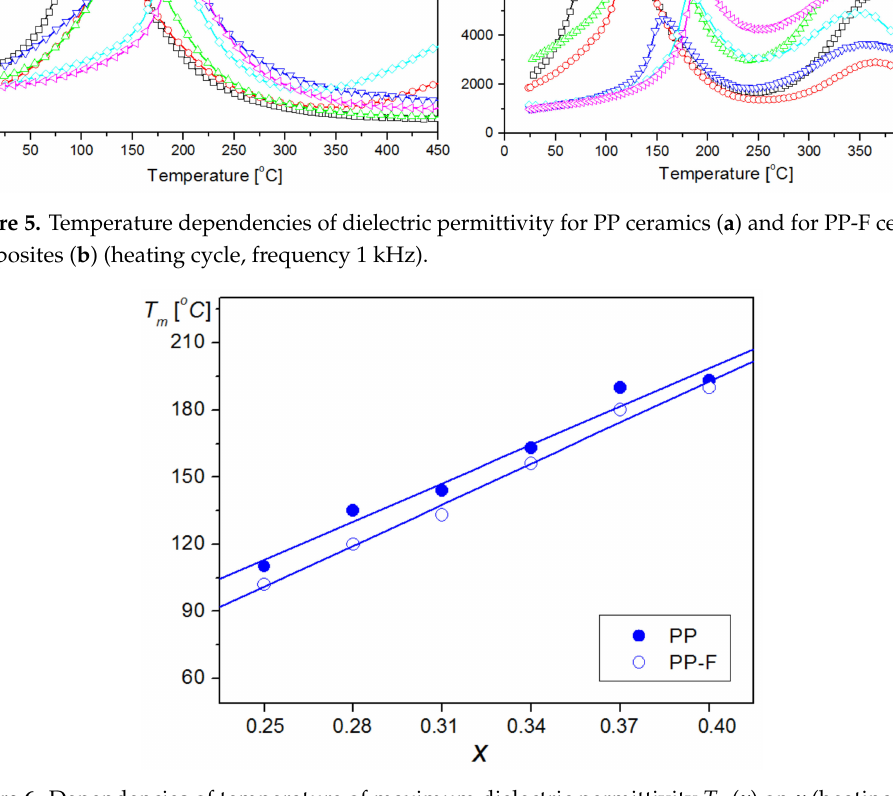
Figure 6. Dependencies of temperature of maximum dielectric permittivity T m ( x ) on x (heating cycle, frequency 1 kHz). Table 1. Electrophysical parameters of PMN-PT solid